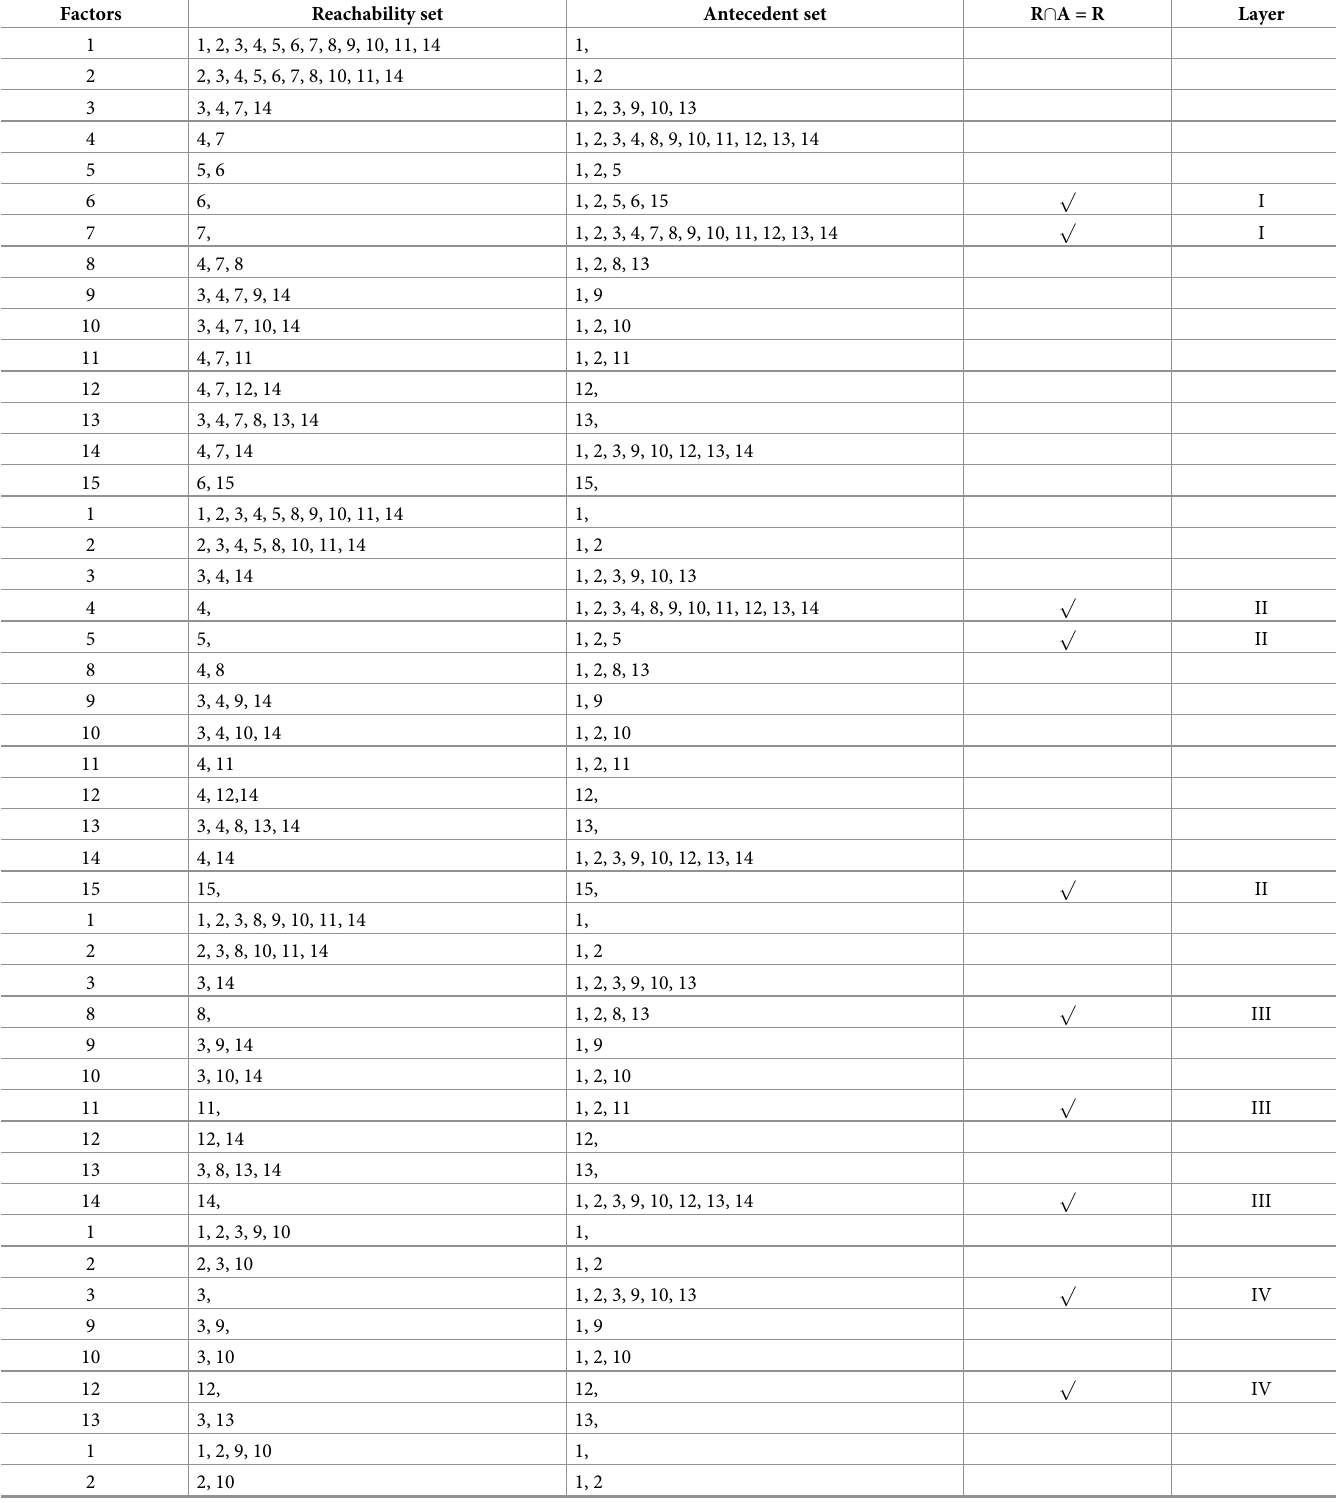
Table 5. Hierarchical analysis of proposed